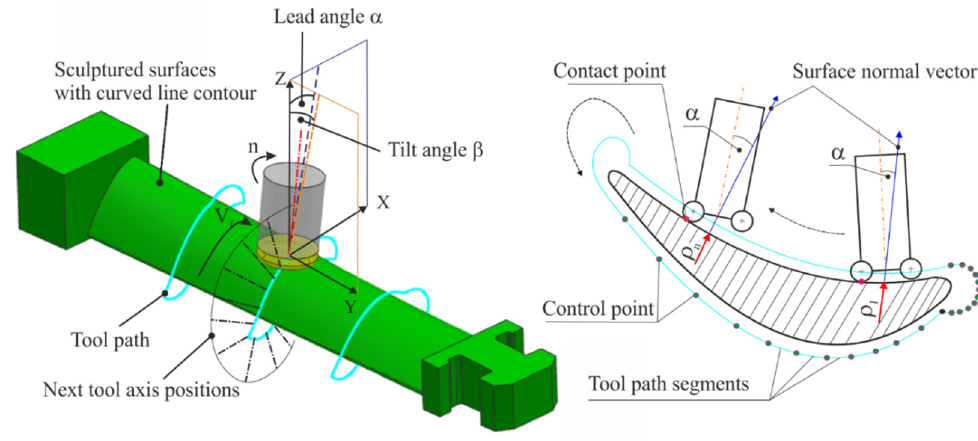
Figure 1. Five-axis milling of sculptured surfaces elements with a curved line contour.